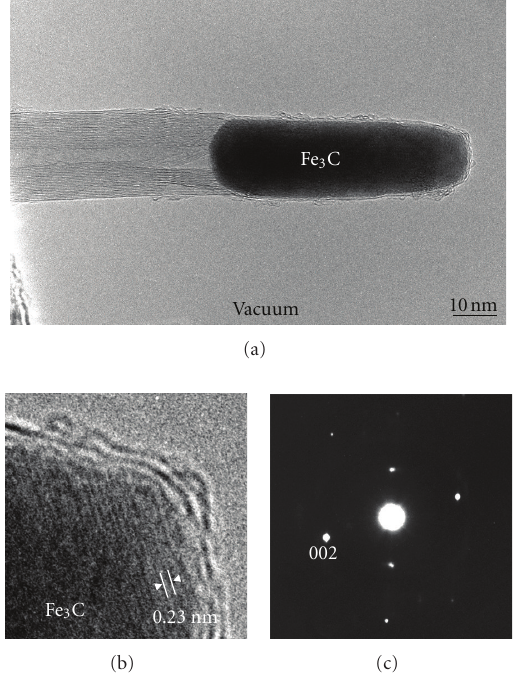
Figure 8: (a) High-resolution image of Fe 3 C-encapsulated carbon nanotube. (b) Enlargement of the nanotube tip in (a). (c) Selected- area electron di ff raction pattern of the Fe 3 C particle encapsulated by the nanotube in